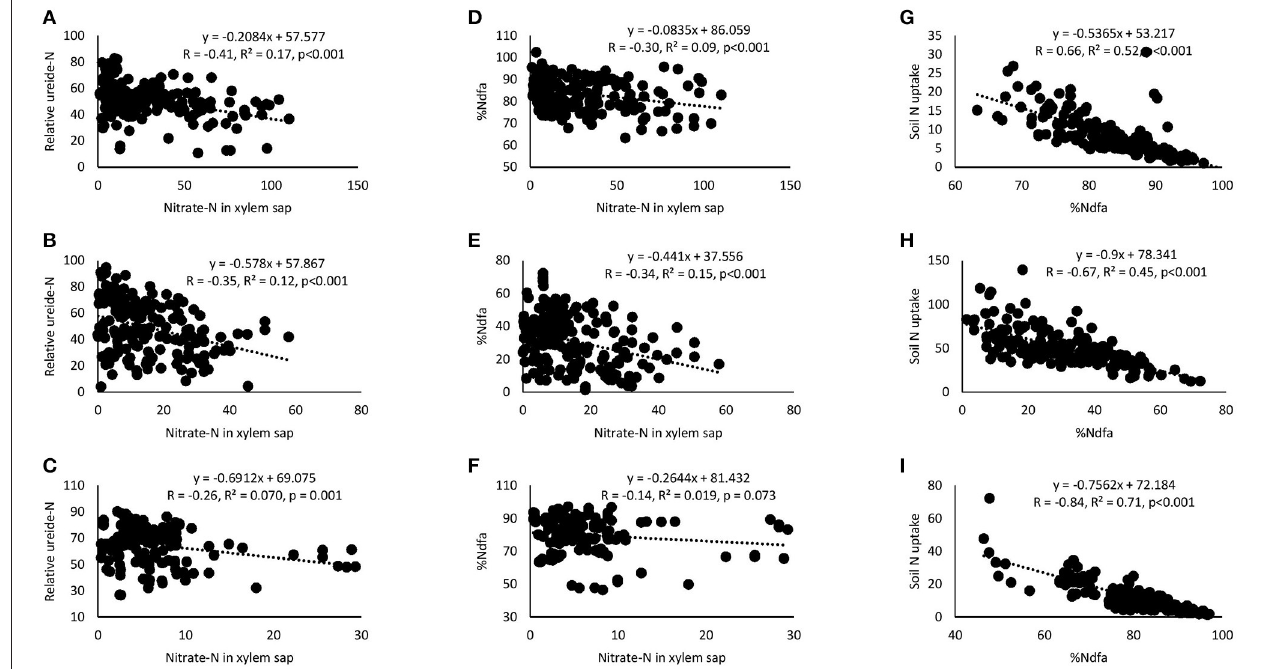
FIGURE 4 | Correlation and regression analysis between xylem nitrate-N and relative ureide-N (RU-N) of 15 cowpea genotypes planted in (A) Nyankpala, (B) Savelugu, and (C) Gbalahi, and between xylem nitrate-N and %Ndfa at (D) Nyankpala, (E) Savelugu, and (F) Gbalahi, and between %Ndfa and soil N uptake in (G) Nyankpala, (H) Savelugu, and (I) Gbalahi.